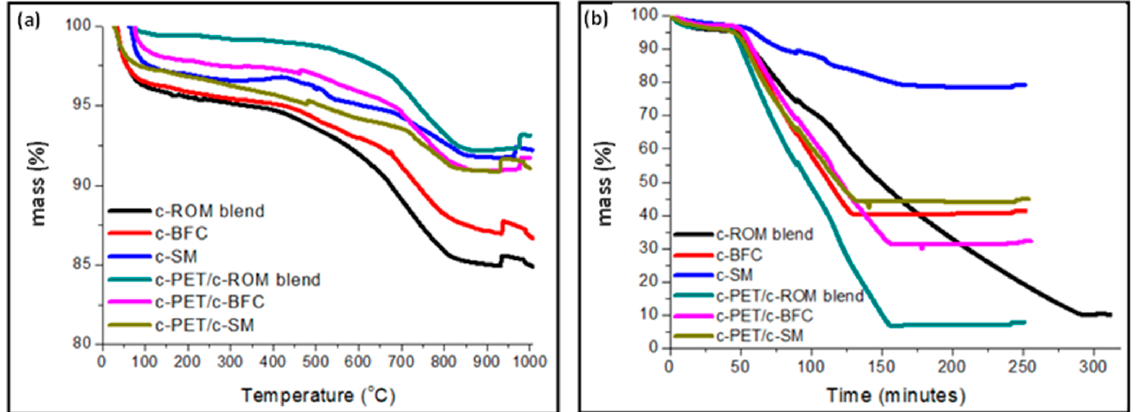
Figure 9. TGA thermograms for d-coal samples and their c-PET/d-coal composite counterparts. Each sample was carbonized at 700 ◦ C under constant nitrogen flow prior to analysis: ( a ) thermal analysis under Argon (Ar) flow at a flowrate of 3 L/hour and heating of 10 ◦ C/min up to 1000 ◦ C and ( b ) thermal analysis in static air at 10 ◦ C/min up to 1000 ◦ C (reached after 100 min) and held at 1000 ◦ C until no weight change was observed.